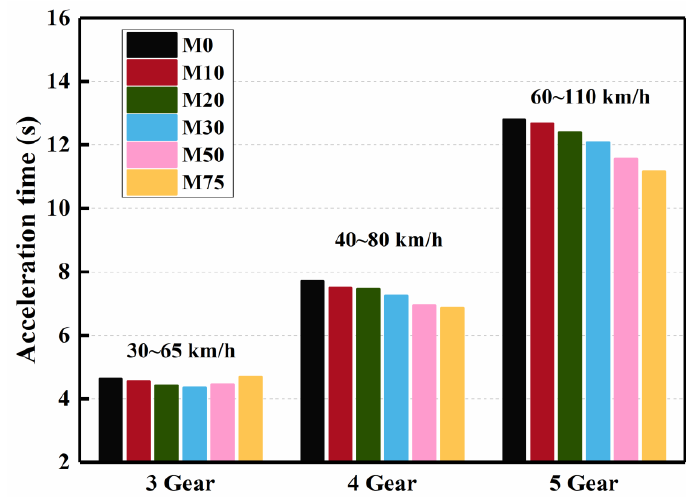
Figure 11. Effects of different methanol blending ratios on acceleration time at different gear